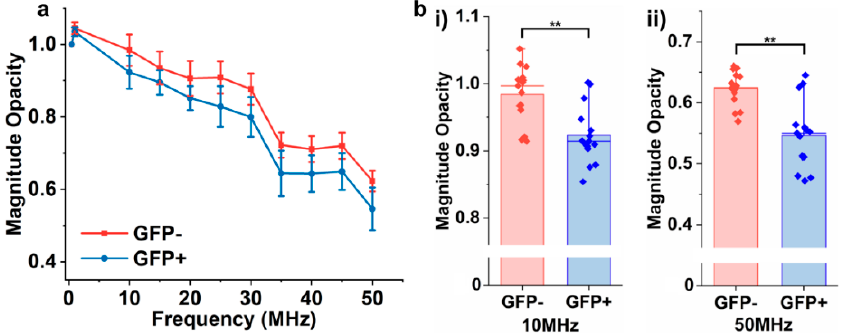
Figure 4. ( a ) The magnitude opacity spectrum of EVs derived from wildtype primary hepatocytes (GFP − ) and GPF+ hepatocytes. ( b ) Significant differences in magnitude opacity were observed at 10MHz and higher frequencies up to 50 MHz. (** P < 0.05, n = 15.)